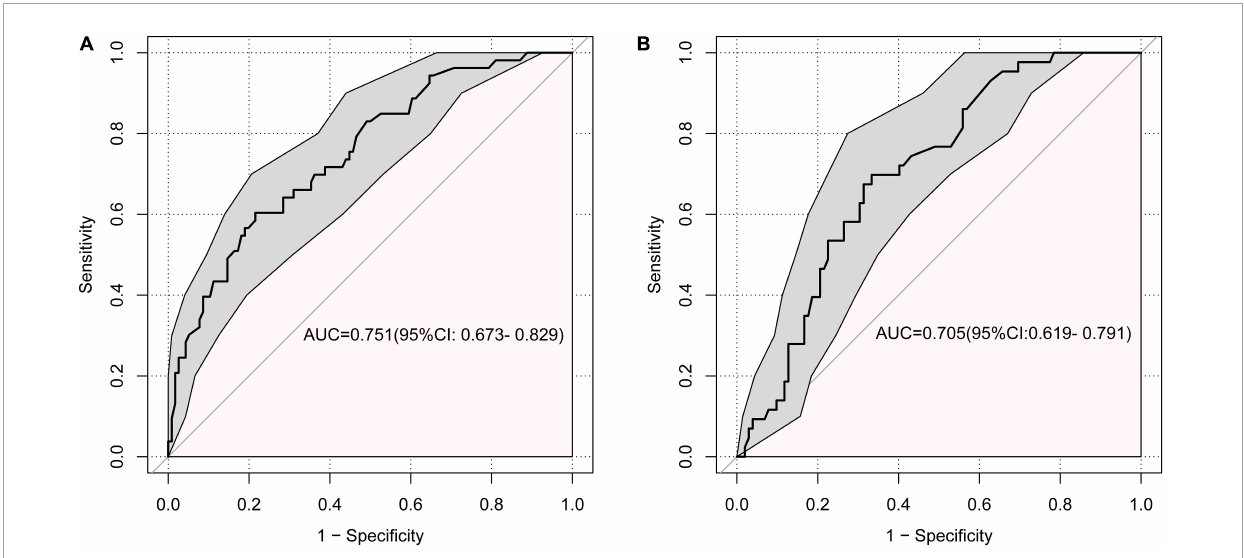
FIGURE4 Receiver operating characteristic curve (ROC) for the discrimination of the model. (A) The training set, 0.751 (95% CI: 0.673–0.829). (B) The validation set, 0.705 (95% CI: 0.619–0.791).